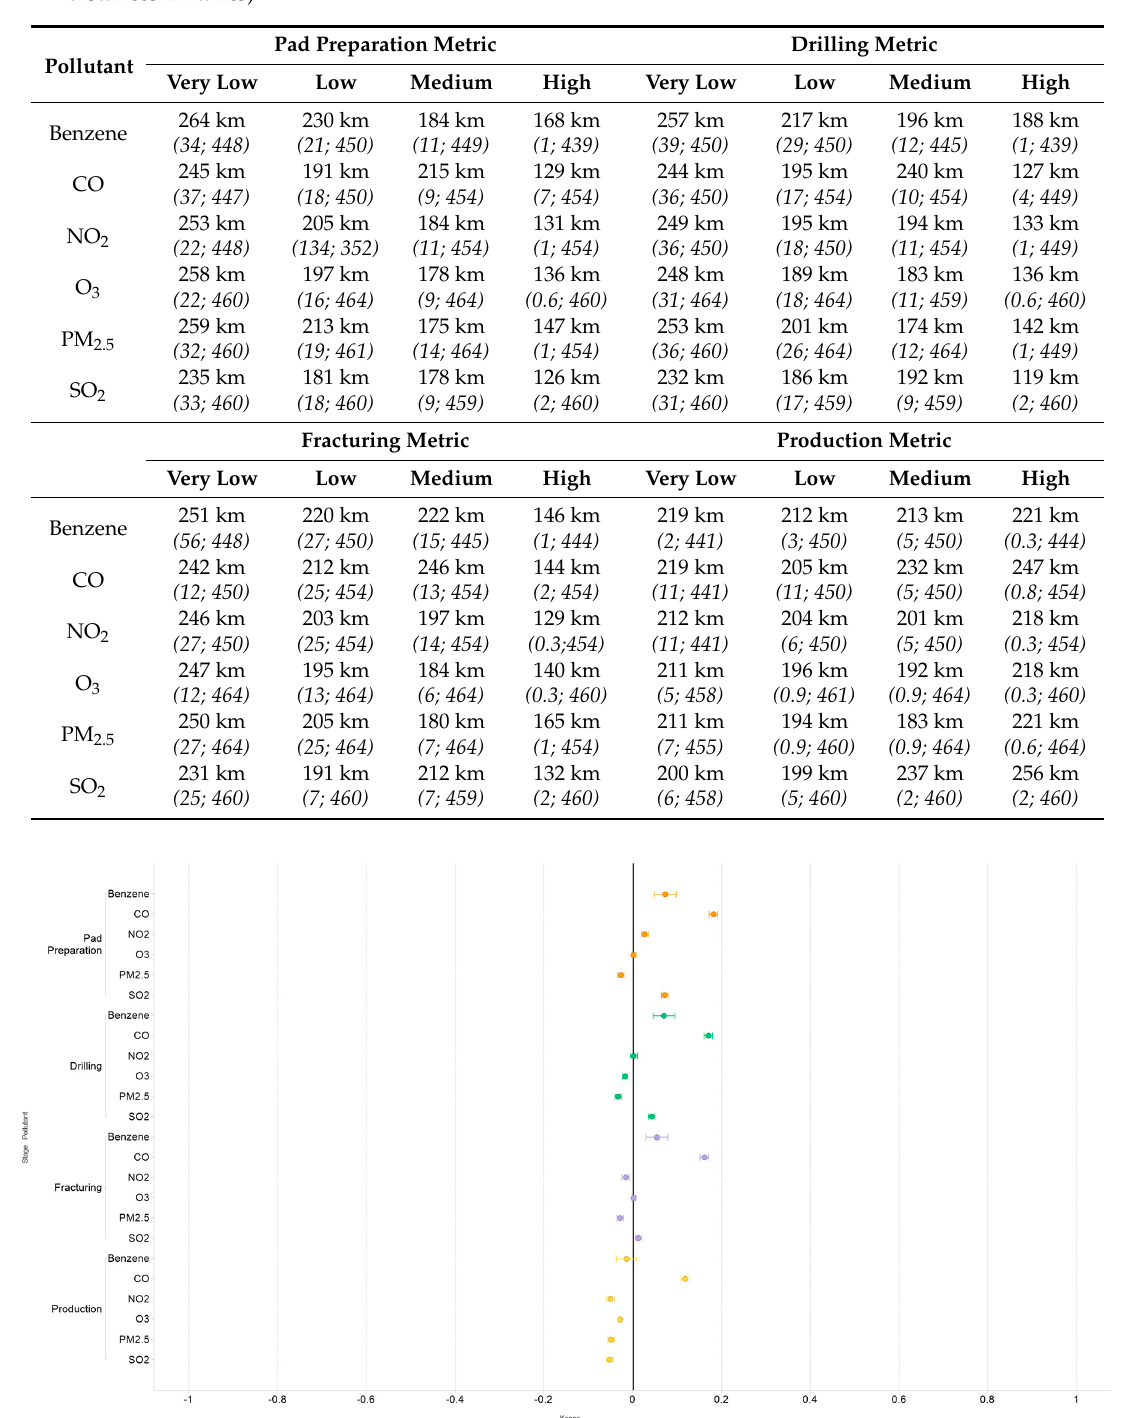
Table 2. Median distances between monitoring sites and statewide wells by phase of well development and exposure category (excluding Philadelphia-area monitors), 2011–2015 (minimum and maximum distances in italics).